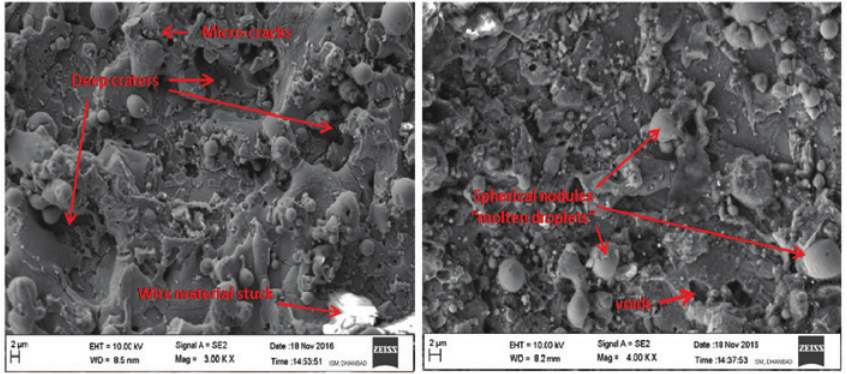
Figure 10: FE-SEM images of the machined